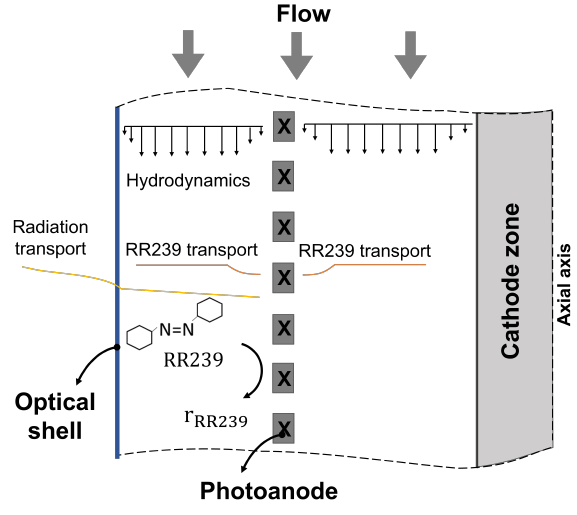
Figure 4. Photoreactor simplified computational